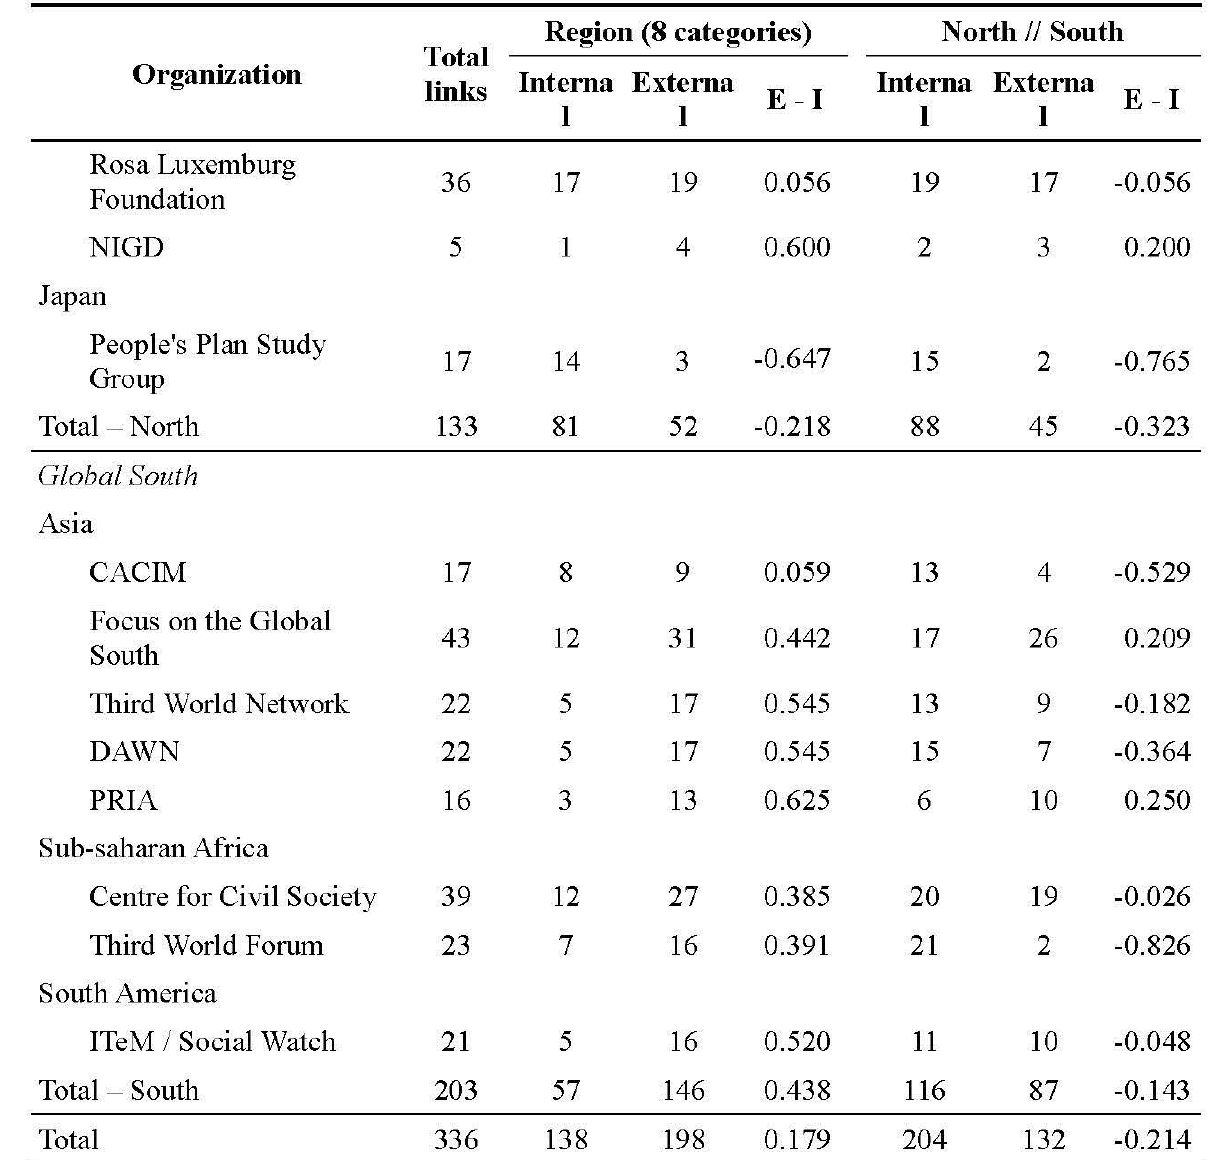
Table 6. Extraversion - Introversion of individual TAPGS